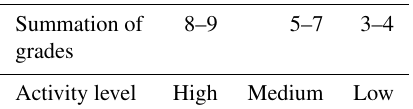
Table 5. Activity level of landslide (modified from Lin,